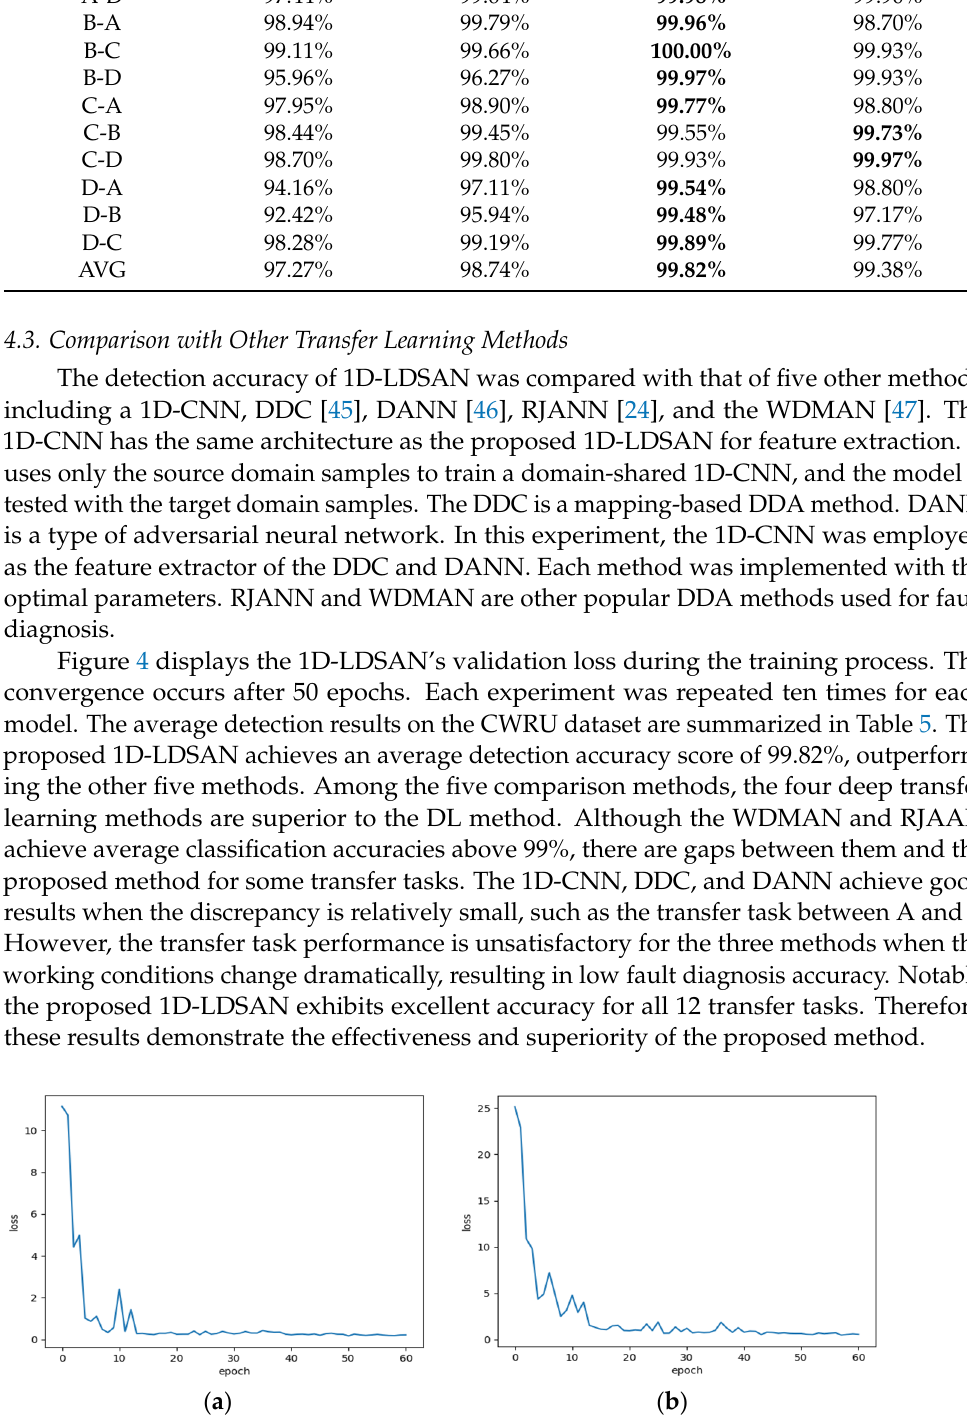
Figure 4. The validation loss of the 1D-LDSAN during the training on the CWRU dataset. ( a ) Source domain; ( b ) target domain. Table 5. Classification accuracies of the different methods on the CWRU dataset. The numbers in bold indicate the highest classification accuracy in corresponding task.